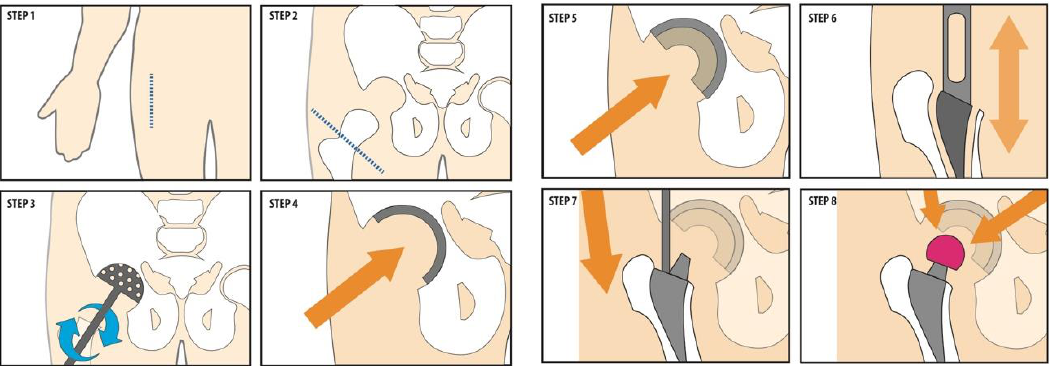
Figure 5. The procedural steps of Total Hip Arthroplasty (THA) Surgery. Step 1. Incision ; Step 2 . Cutting the Femoral neck; Step 3. Reaming the Acetabular; Step 4 . Placement of Acetabular cup; Step 5. Placement of Acetabular cup liner; Step 6. Opening the Femoral canal; Step 7. Placement of Femoral stem; Step 8. Placement of Femoral head. The arrows indicate the force applied by the surgeon with a surgical hammer which as a consequence produces sound.